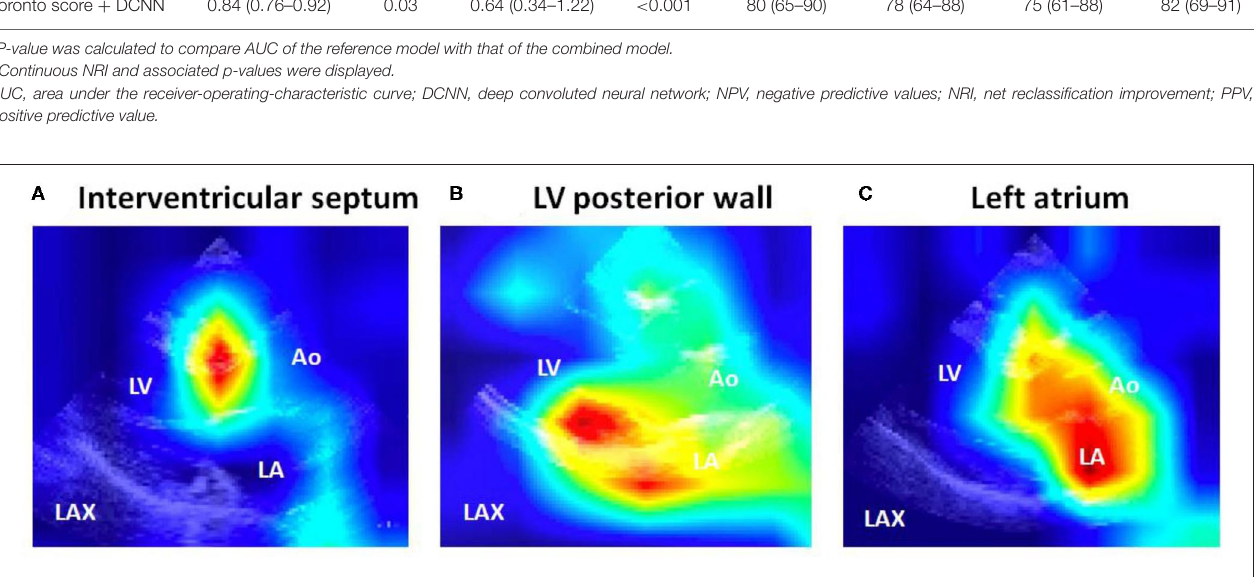
FIGURE 3 | Spatial display of important features detected by the deep convoluted neural network analysis models. Note that the important features were localized to (A) the interventricular septum, (B) the LV posterior wall, and (C) the left atrium. Ao, aorta; LA, left atrium; LAX: parasternal long-axis view; LV, left